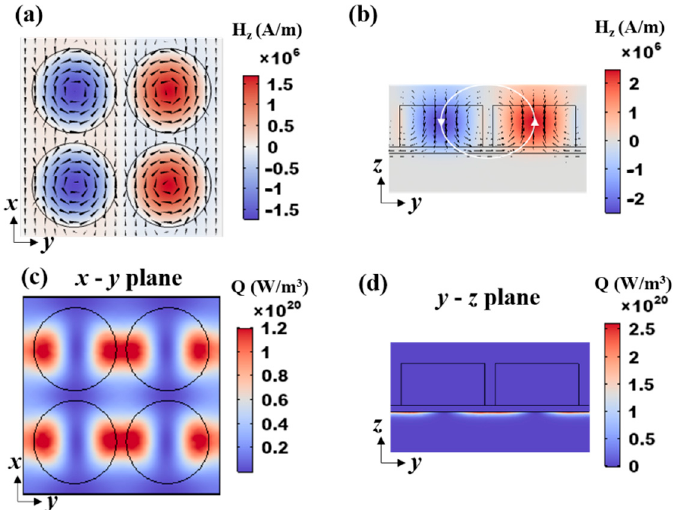
Figure 4. Electromagnetic field distribution at resonant wavelength. ( a ) Magnetic field distribution in x – y plane. Black cones represent the displacement current. ( b ) Magnetic field distribution in y – z plane. Black arrows denote the magnetic field vector. ( c ) Electromagnetic power dispassion density distribution in x – y plane and ( d ) y – z plane.